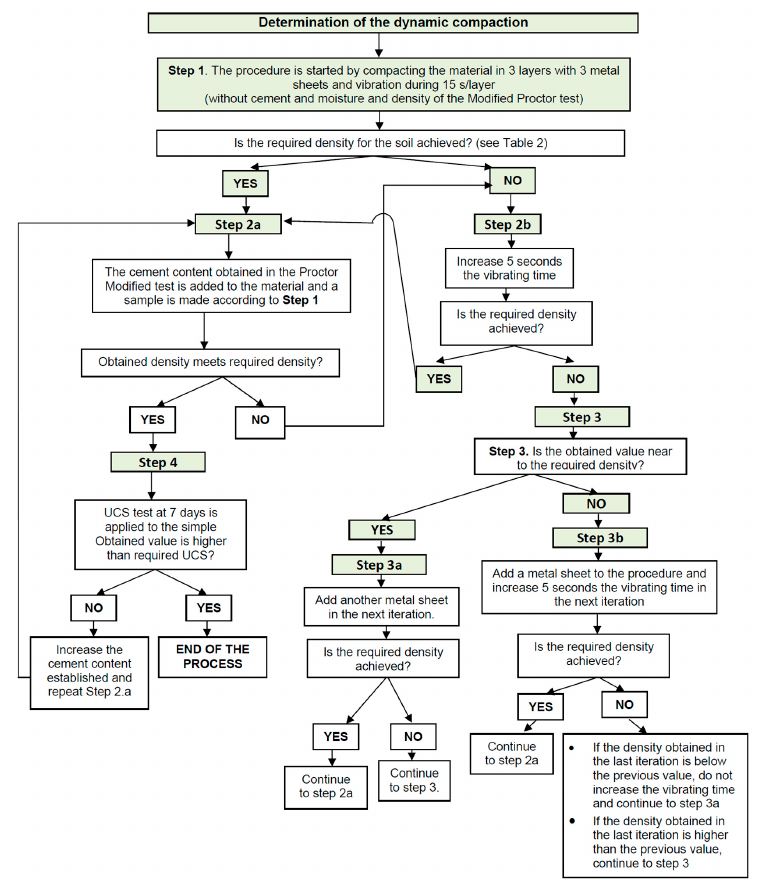
Figure 2. Diagram of the procedure to achieve the required density with the proposed compaction device.